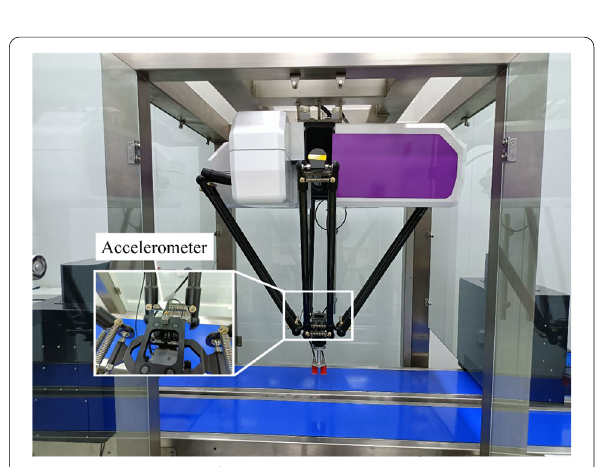
Figure 11 Experimental set-up